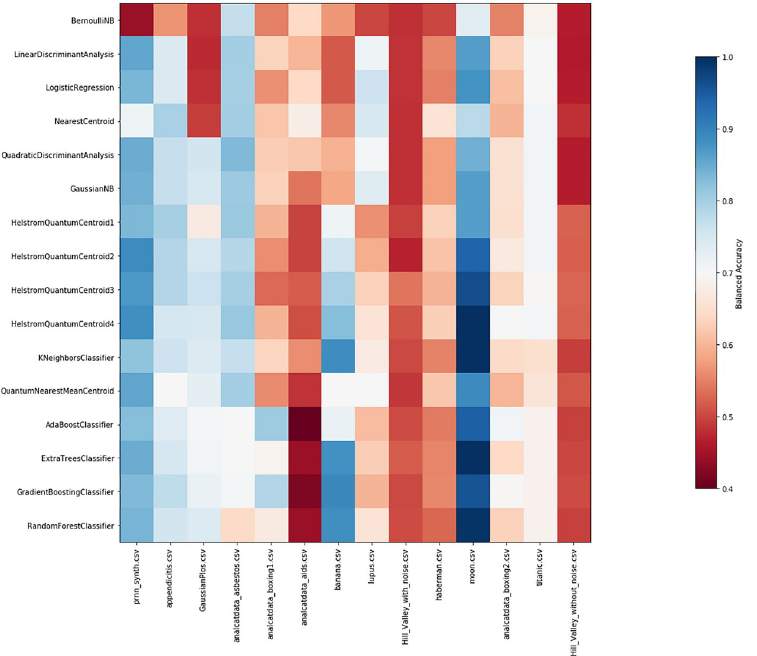
Fig 1. Biclustering of the 16 classifiers and 14 datasets according to Balanced Accuracy.